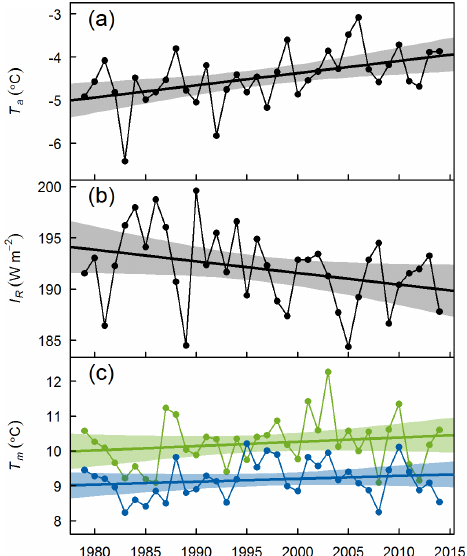
Figure 8. The trends in the annual mean air temperature (a) and solar radiation (b) from ERA-Interim, as well as the trends in the modeled mean summer lake temperature (c) in Ngoring (blue) and Gyaring